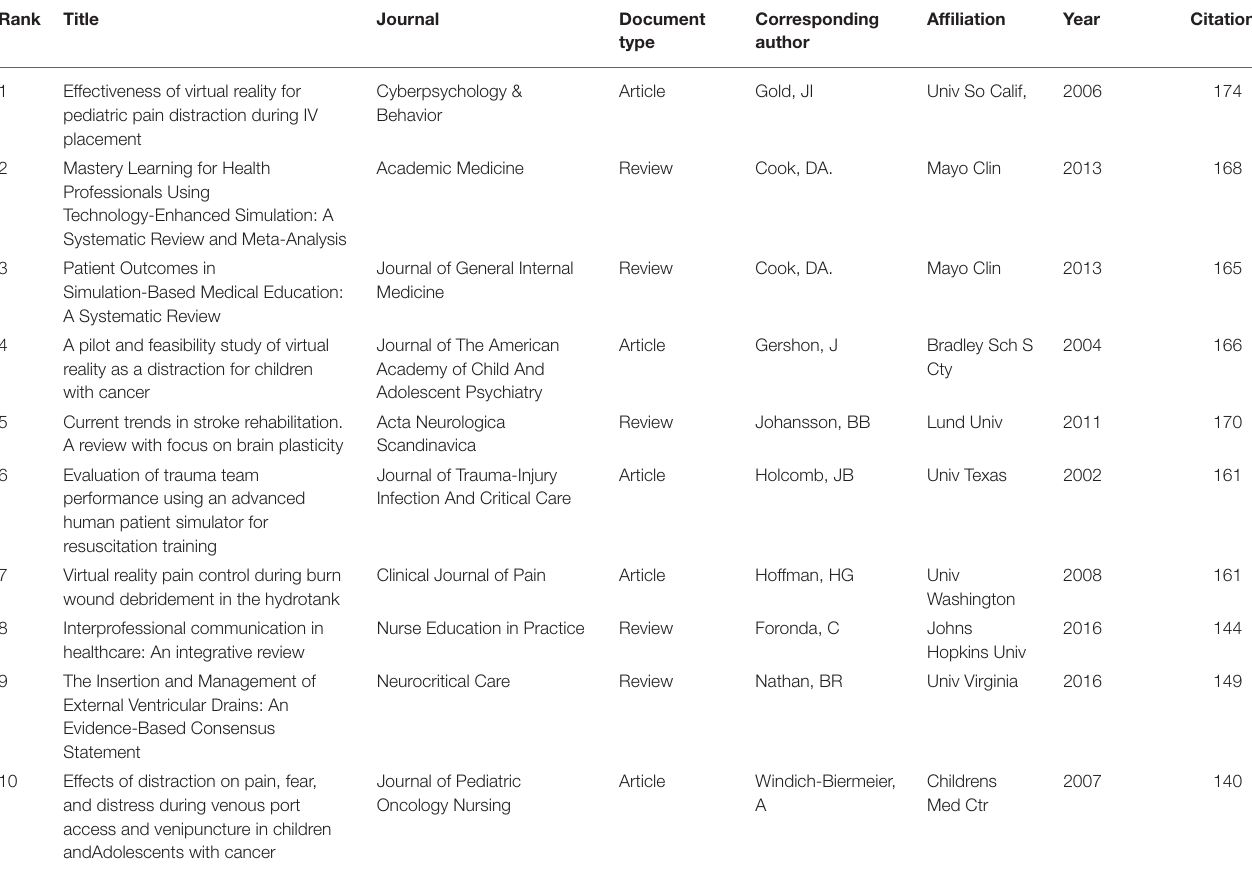
TABLE 3 | Top 10 most cited papers related to virtual simulation research in